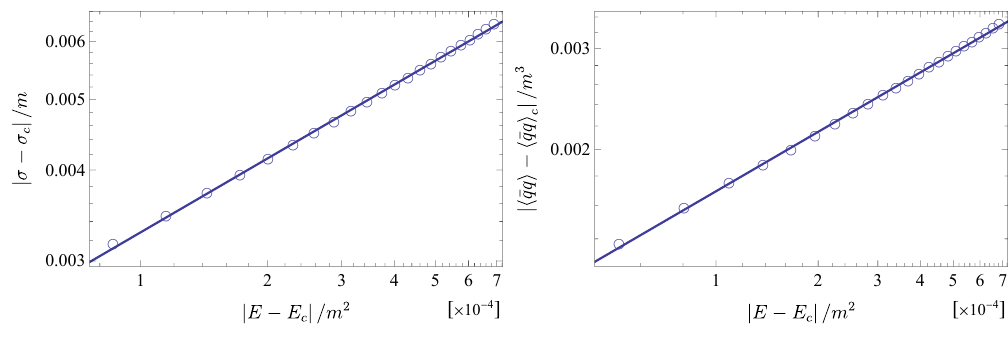
Figure 4 . The critical behaviors of | φ − φ c | with respect to | E − E c | at the critical point. The left (right) panel shows the results with the conductivity (the chiral condensate). The open circles and the solid lines denote the numerical plots and the fitting results,